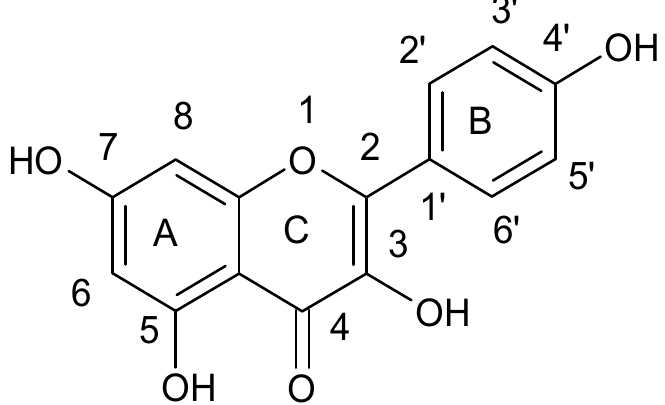
Figure 4. Chemical structure of kaempferol.